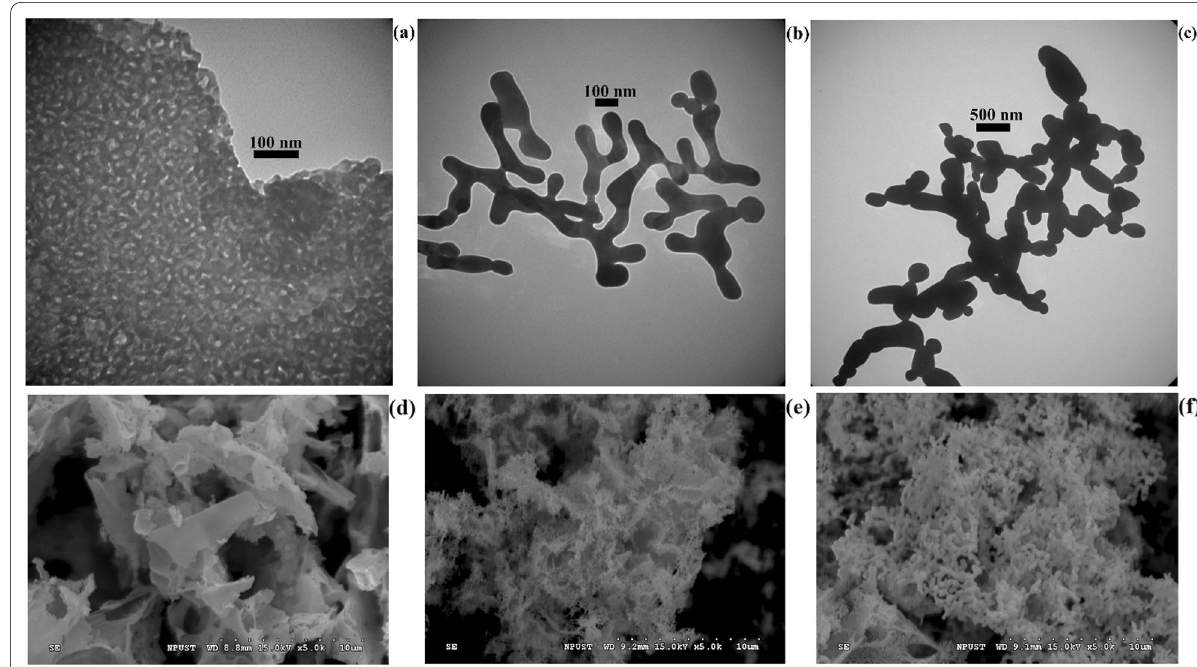
Fig. 2 TEM and SEM images of the samples synthesized at the following conditions: a and d — T A t A 12 h, c and f — T A =